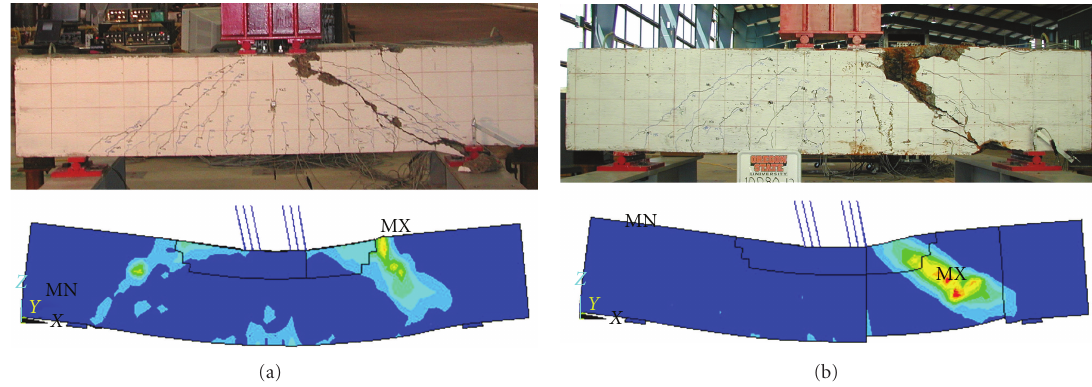
Figure 7: Crack patterns at failure: (a) specimen 10RA and undamaged FE model and (b) specimen 10RD and severely corroded FE